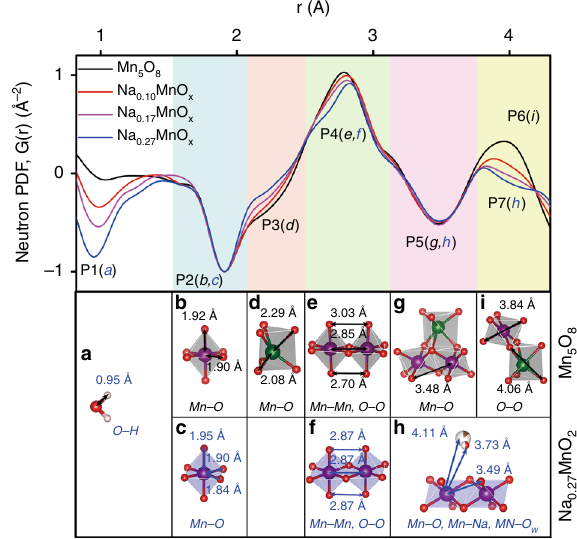
Fig. 2 Neutron PDFs of various Na δ MnO x materials. The atom pair associated with each peak (P1 to P7) can be attributed to a water, b , d , e , g , i Mn 5 O 8 polyhedra in black and c , f , h MnO 2 polyhedra in Na δ MnO x materials (a distance at which the peaks of atomic pairs vanished) decreased from >50 Å to ~30 Å as δ increases, indi- cating more con fi ned crystalline order. Namely, Na δ MnO x materials cannot sustain long-range crystallinity and became more disordered when more Na-ions are incorporated into the structure. Figure 1c shows that as Na concentration ( δ ) increased, Na δ MnO x materials showed pure phase Mn 5 O 8 ( δ = 0), mixture of Mn 5 O 8 and layered MnO 2 ( δ = 0.10 and 0.17). When δ reached 0.27, a pure triclinic birnessite structure formed with an interplanar distance of 7.19 Å. The chemical formula was deter- mined as Na 0.27 MnO 2 ∙ 0.63H 2 O, where the Na + and structural water (determined from thermal gravimetric analysis shown in Supplementary Fig. 5) occupied the interlayers.